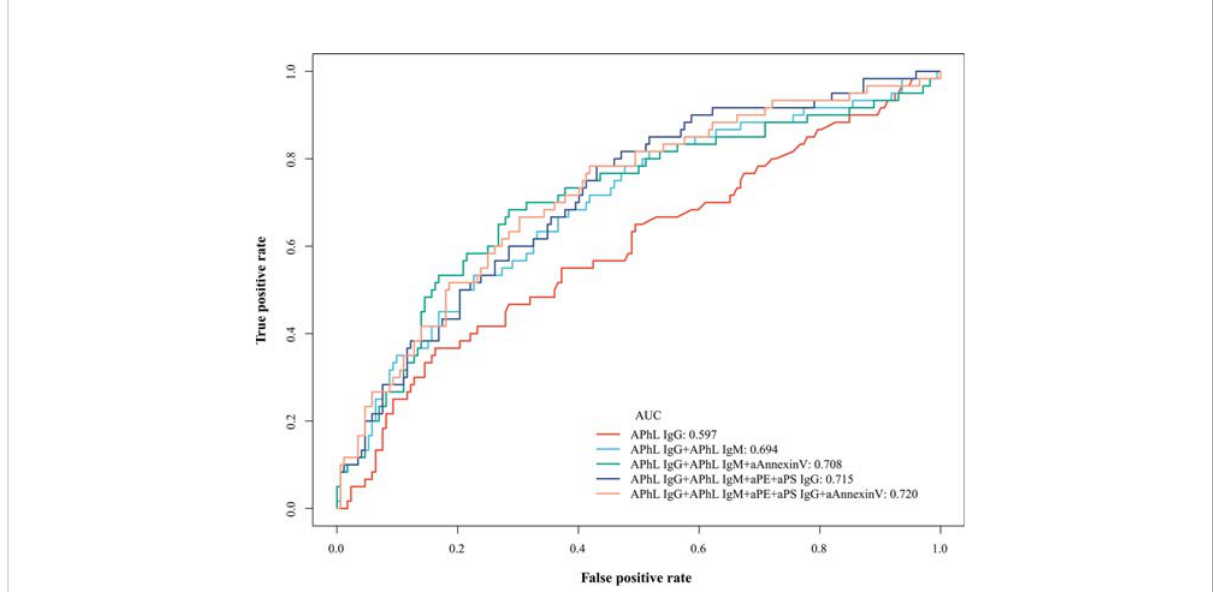
FIGURE 2 Receiver operating characteristic (ROC) curves and area under the curve (AUC) of single or combined non-criteria antibodies among SNAPS patients and controls. In seven single antibodies and combinations of two to fi ve antibodies, the ROC curves with the highest AUC values are shown. Among SNAPS patients, the APhL IgG showed the highest AUC value in single antibodies. The APhL IgG/IgM showed the highest AUC among two antibody combinations, and the same is true of the other three combinations.